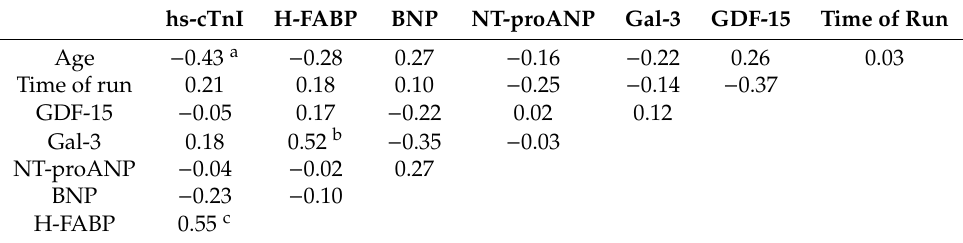
Table 5. Correlations between biomarkers, age and time of run at